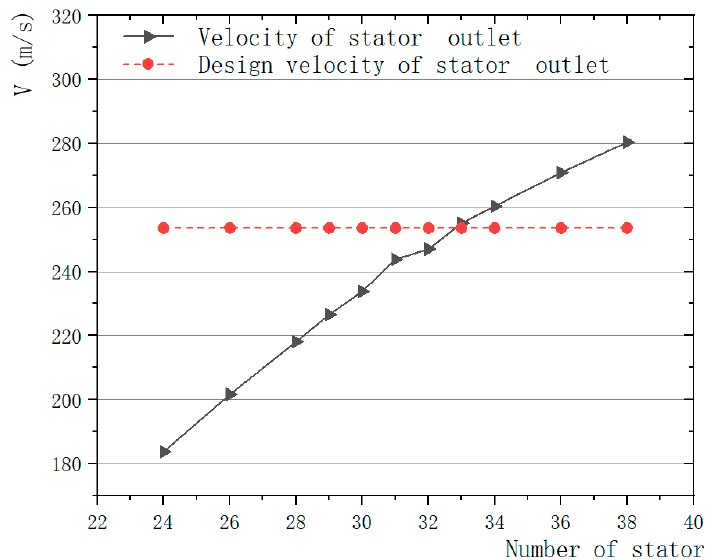
Figure 11. Comparison of design value and simulation value of stator outlet velocity under different at different number of stator blades.